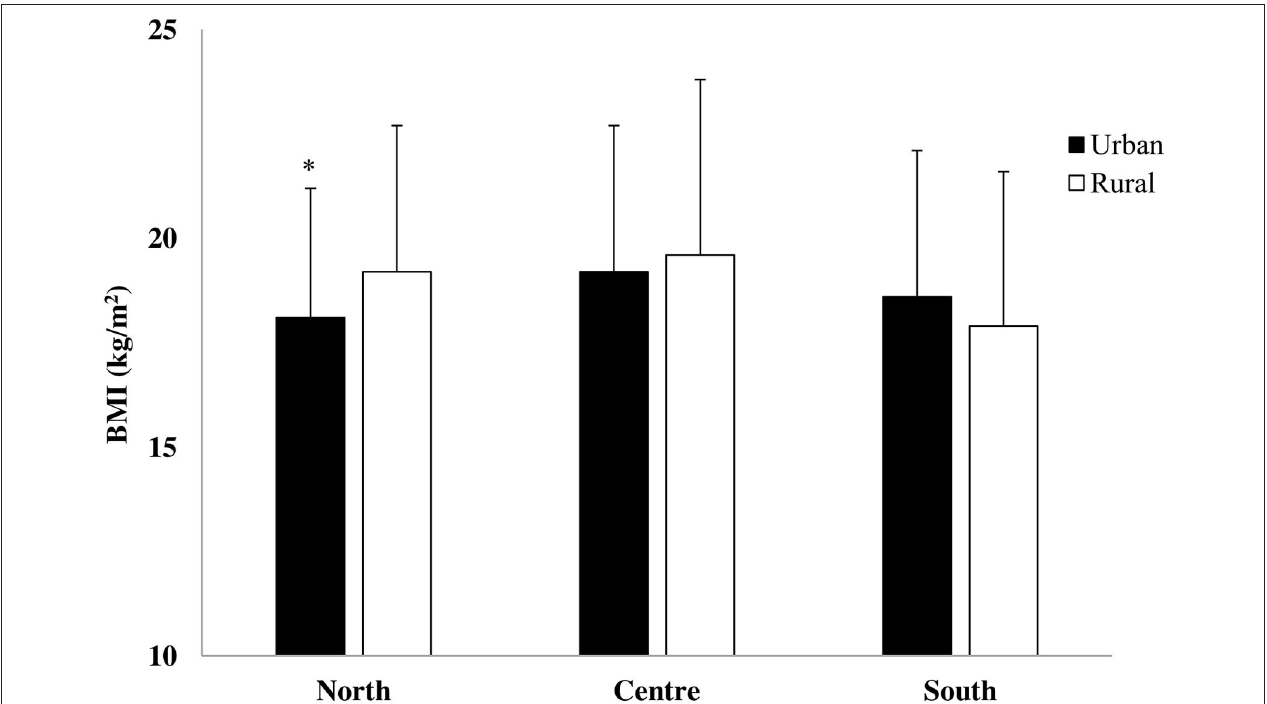
FIGURE 1 | Body mass index (BMI) in urban and rural children of the North, Center, and South of Italy (* p = 0.0001 urban vs. rural).